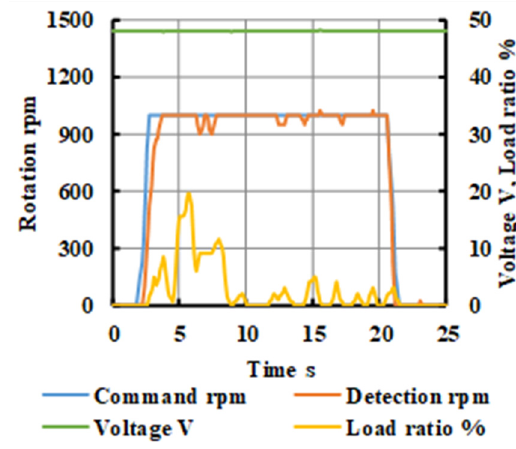
Figure 16. Results of high-speed step overcoming test.